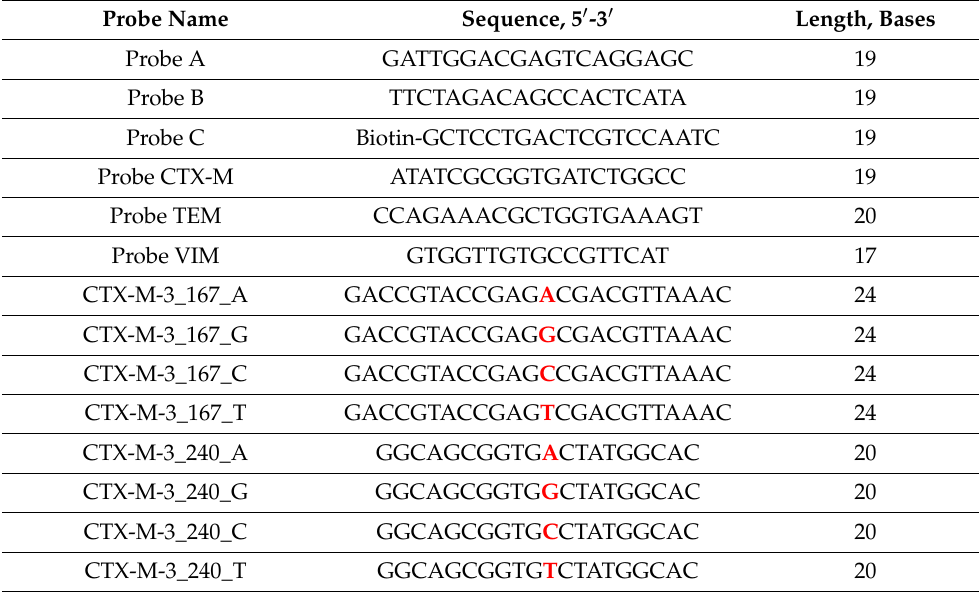
Table 1. Oligonucleotide probe sequences used in this